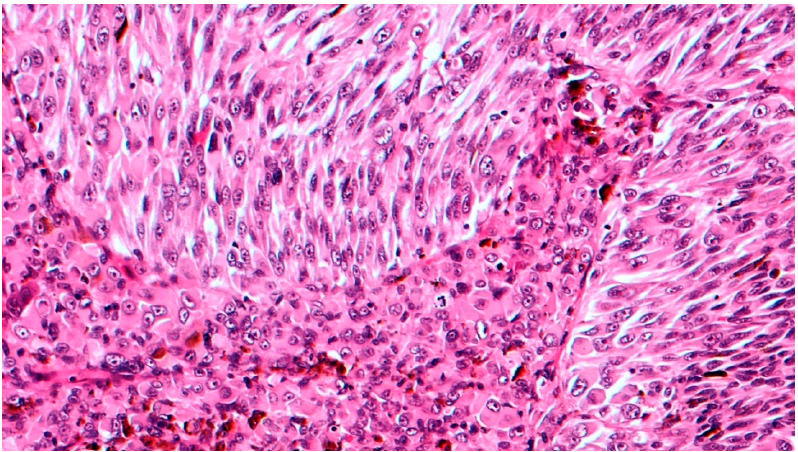
Figure 4. High magnification showing mixed cell type choroidal melanoma, composed of both epithelioid and spindle cells (hematoxylin and eosin; original magnification 200×).